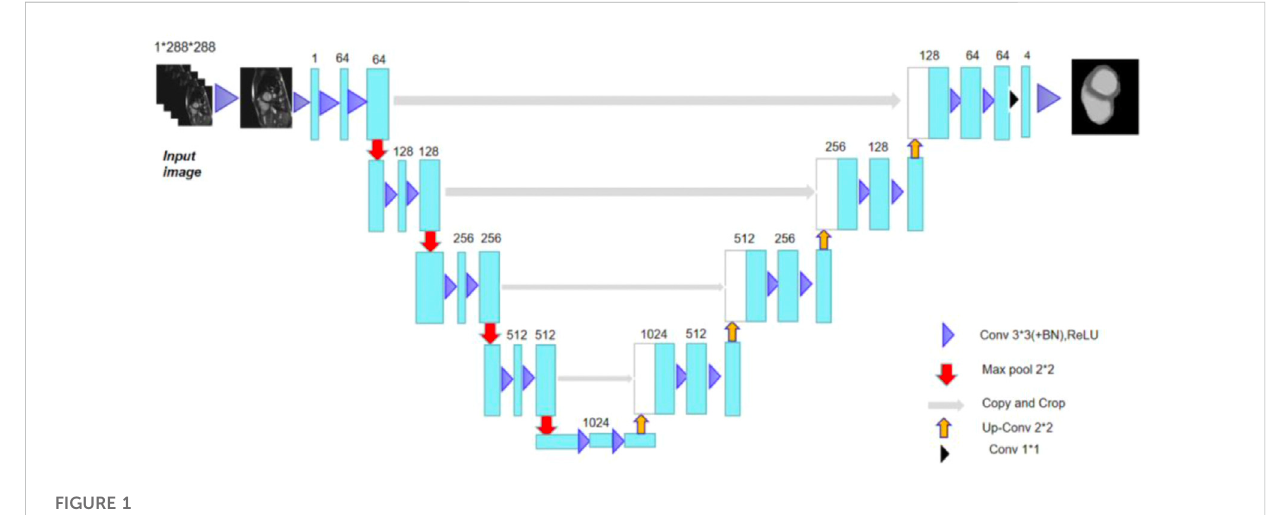
FIGURE 1 Classic U-network structure for the purpose of cardiac MRI image